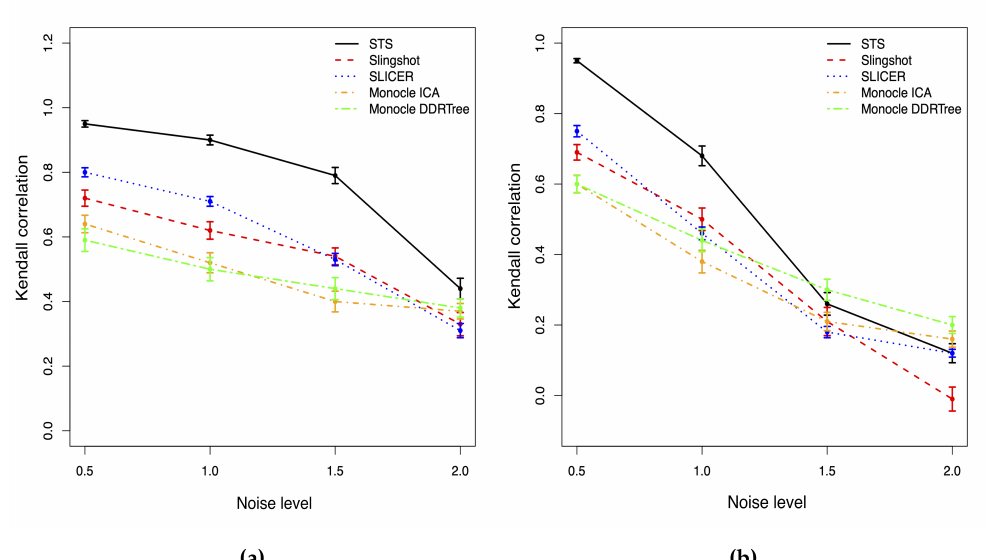
Figure 2. Kendall correlations with different noise level for two different noise distribution cases.